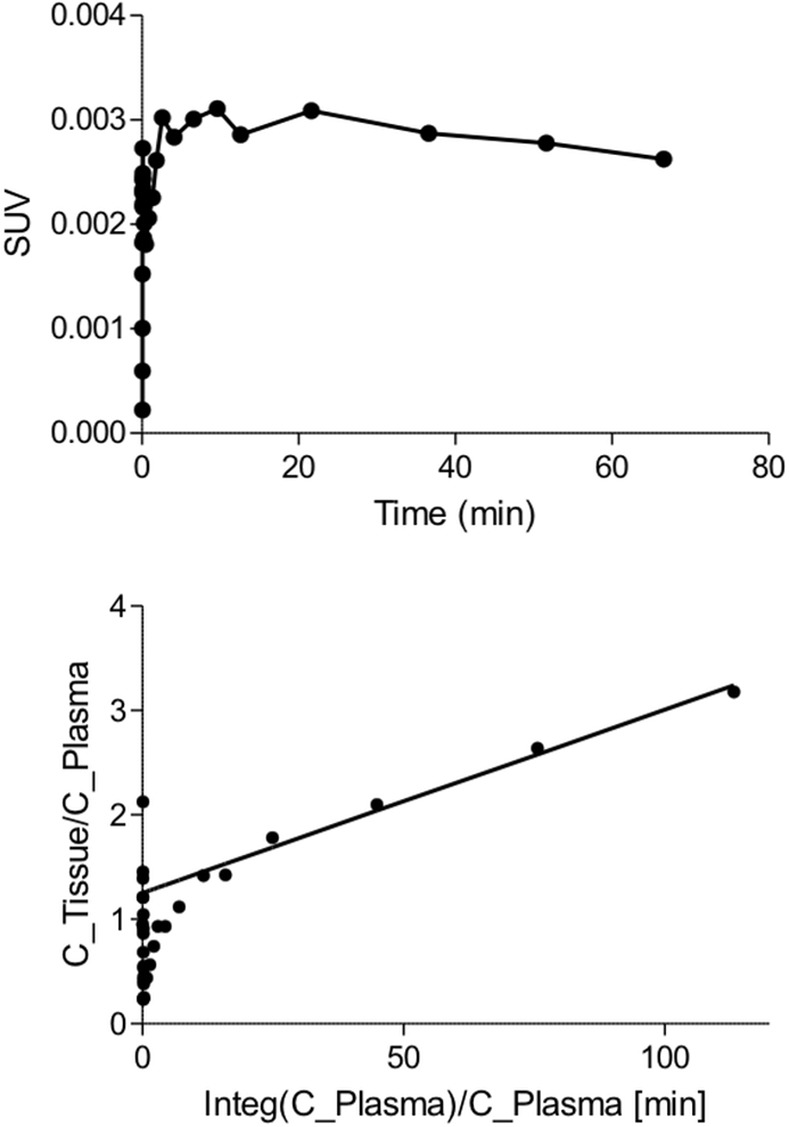
(A) Average brain time-activity curve used to quantify CMRglc. (B) Example of Patlak linearization using a scaled SAIF.